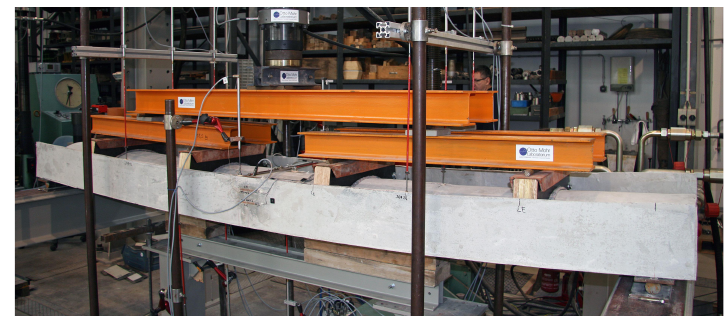
Figure 5. Test setup of the carbon concrete